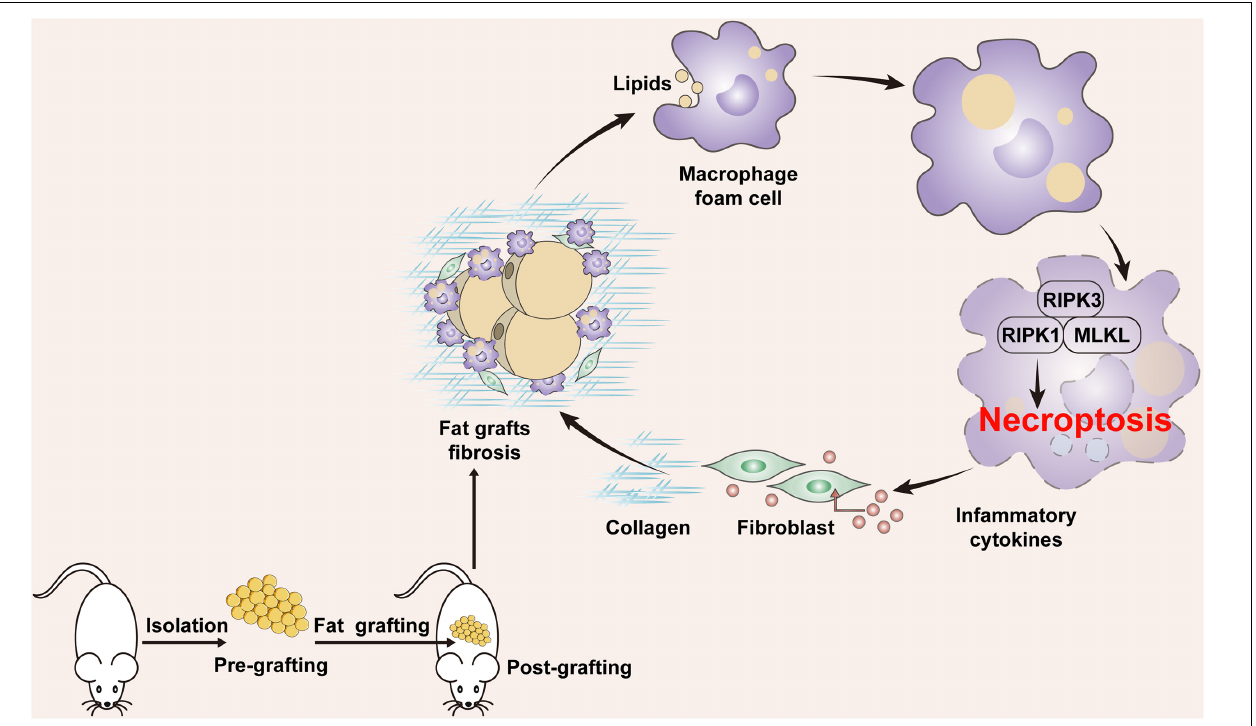
FIGURE 9 | Potential role of MFC necroptosis in fat graft fibrosis. After fat grafting, lipids released from apoptotic adipocytes induce formation of MFCs and an increased level of cellular lipids mediates necroptosis of MFCs, which upregulates the expression of proinflammatory cytokines/chemokines, leading to collagen synthesis by fibroblasts. Consequently, overproduction of collagens leads to fat tissue fibrosis after